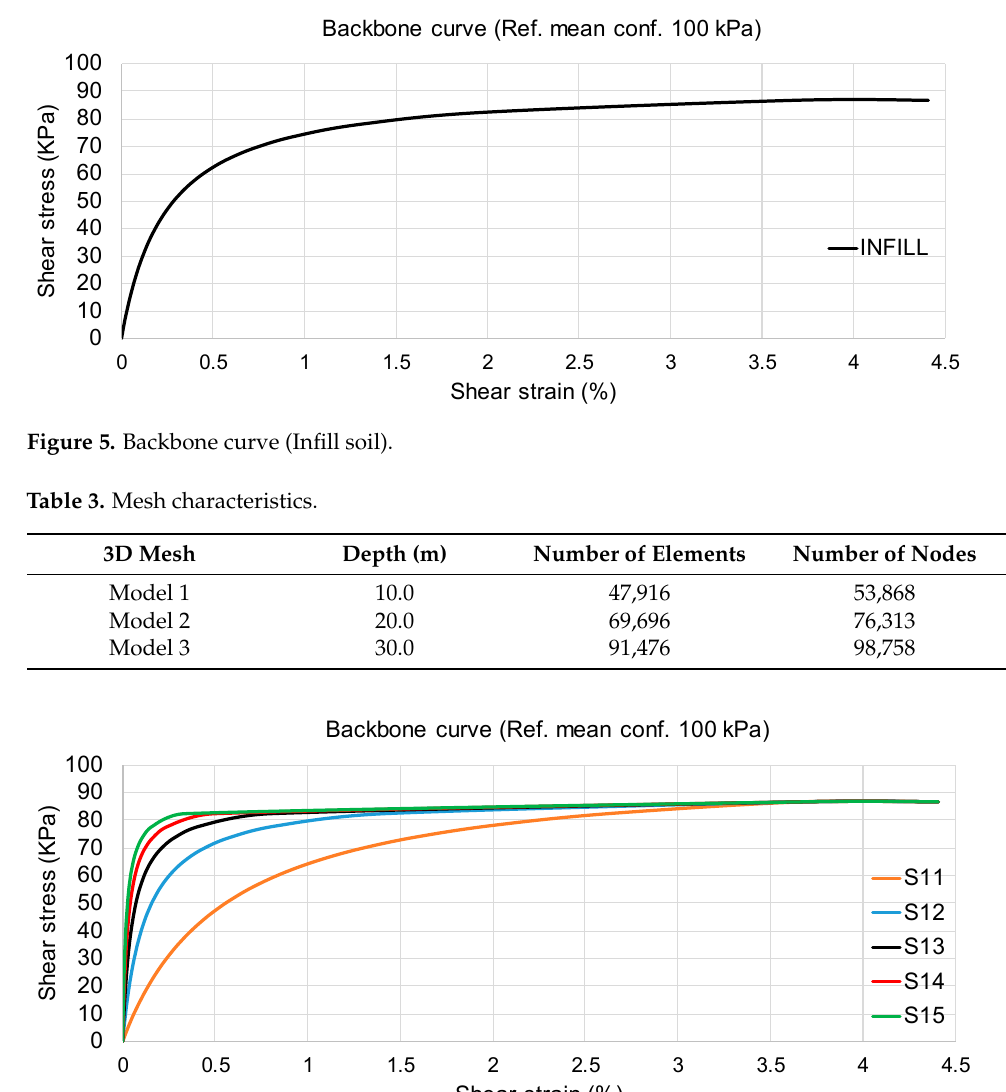
Figure 4. Three-dimensional (3D) mesh (Model 3).